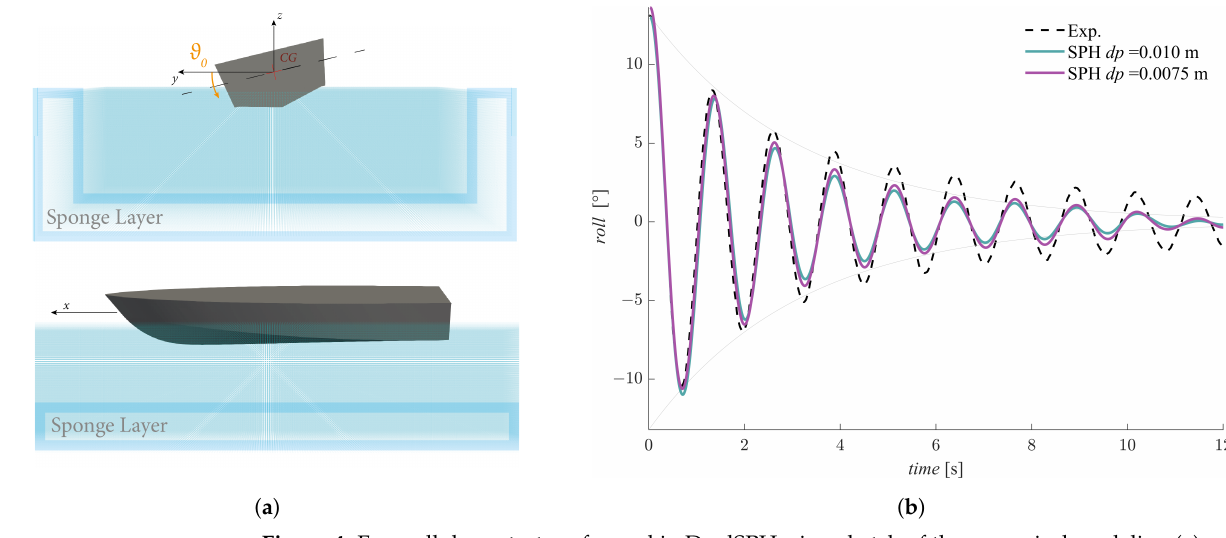
Figure 4. Free roll decay test performed in DualSPHysics: sketch of the numerical modeling ( a ) and comparison between experimental and numerical roll amplitudes with different SPH resolutions ( b